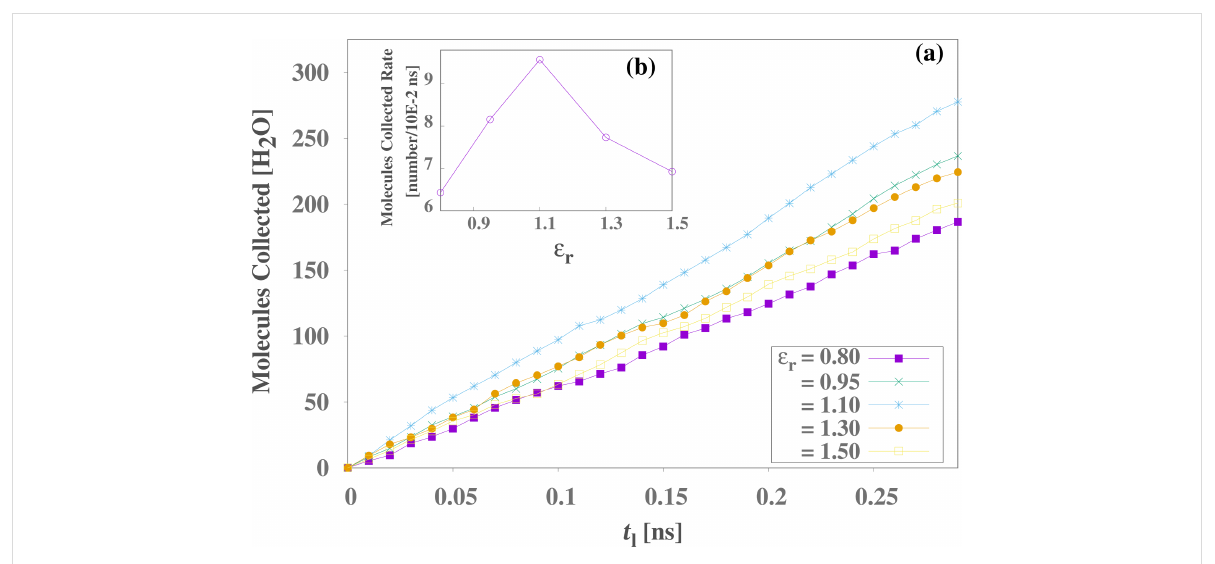
Figure 9: (a) Number of collected molecules as a function of the time (ns) for different ε r . (b) Mean collected rate (MCR) as a function of ε r .